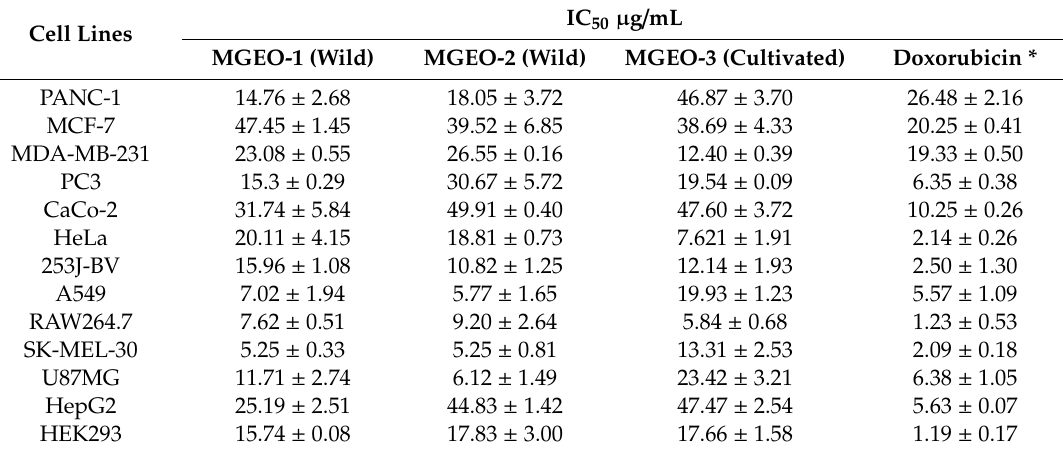
Table 4. IC 50 values (mean ± SD, µ g / mL) of MGEOs 1 to 3 for cell lines after 48 h exposure to di ff erent MGEO concentrations.